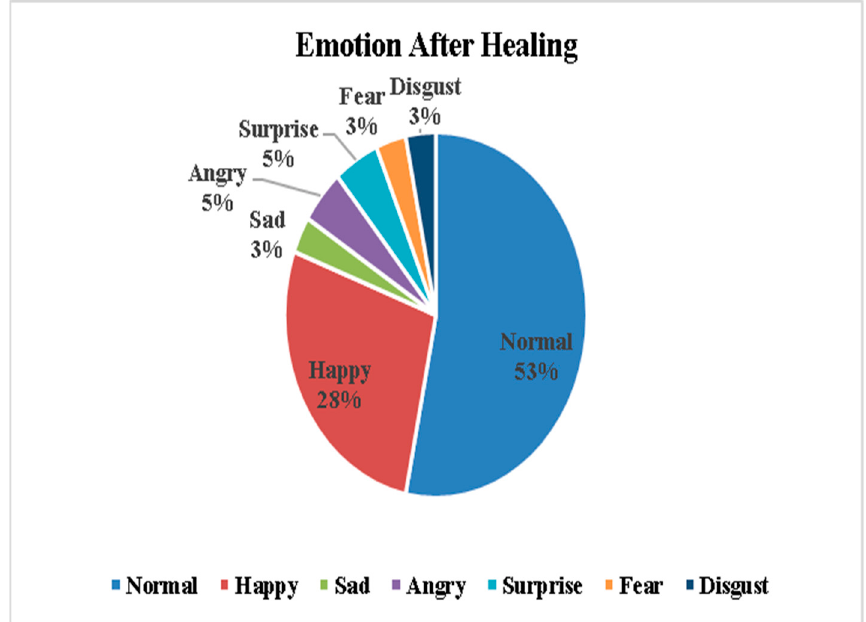
Figure 13. Participants’ emotions before healing.